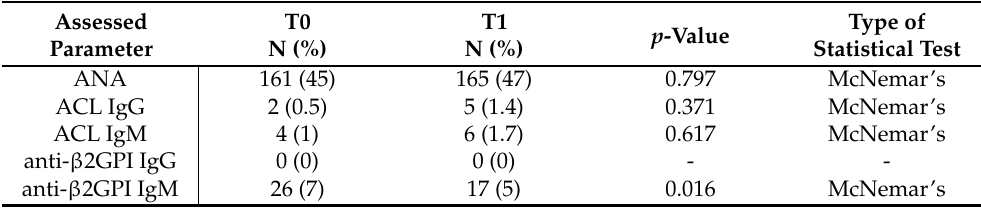
Table 2. ANA, ACL IgG/IgM, anti- β 2GPI IgG/IgM assays in the study group, performed before vaccine administration and 7–9 months after basic immunisation.